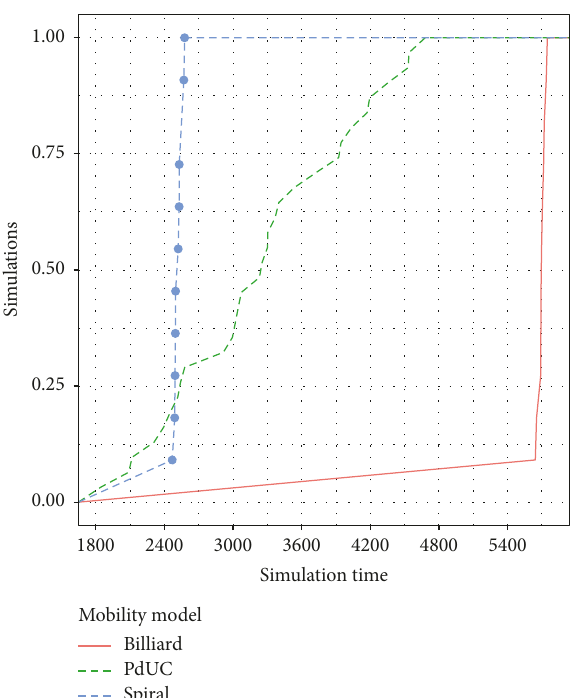
Figure 12: Relative error comparison between the PdUC, Billiard, and Spiral mobility models at different times, when analyzing all the